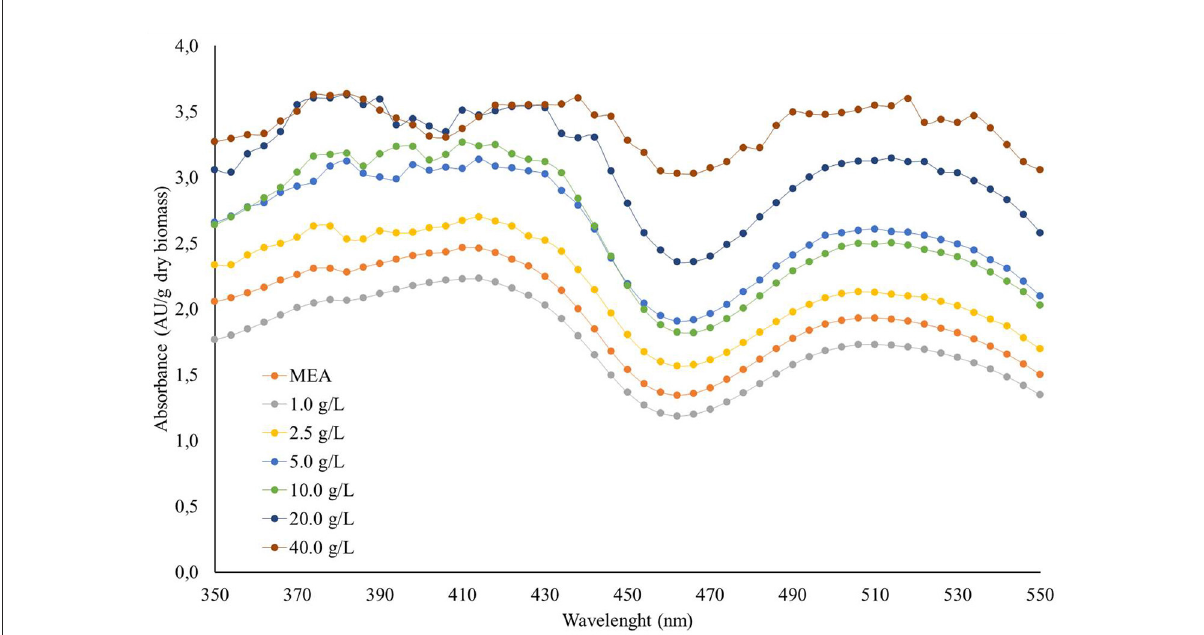
FIGURE3 Scanning spectrum of pigments produced by the colonies of Monascus ruber CCT 3802 grown in different concentrations of maltose syrup.